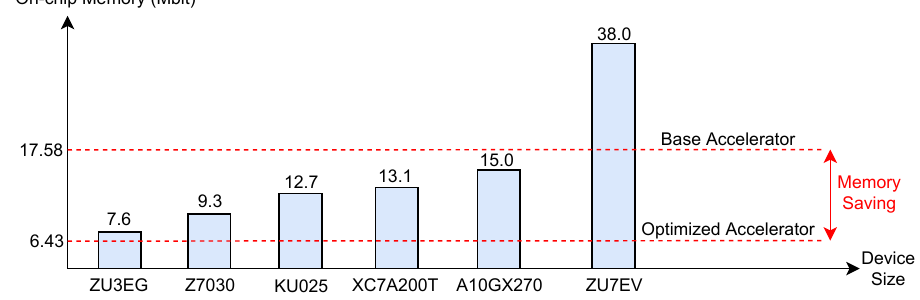
Figure 8. FPGA memory budgets and system memory requirements. The red dashed lines represent the memory footprints required by the two accelerators under analysis. As the figure suggests, the implementation of the system without the proposed memory improvements is not feasible on the new set of devices due to the reduced memory